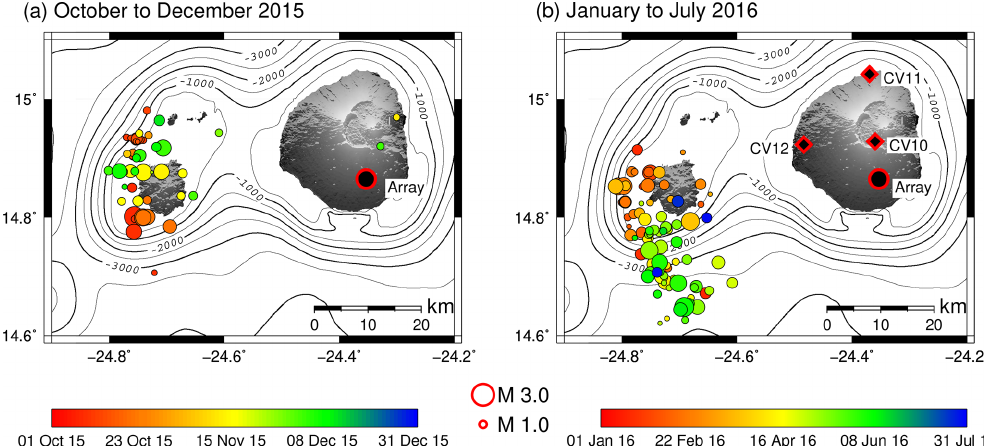
Figure 5. (a) Earthquake locations from 8 October to 19 December 2015. Red/black circle: position of the array on Fogo. (b) Earthquake locations from 15 January to 31 July 2016. Red/black circle: position of the array, red/black diamond: additional broadband stations on Fogo. Topographic and bathymetry data are from Ryan et al.